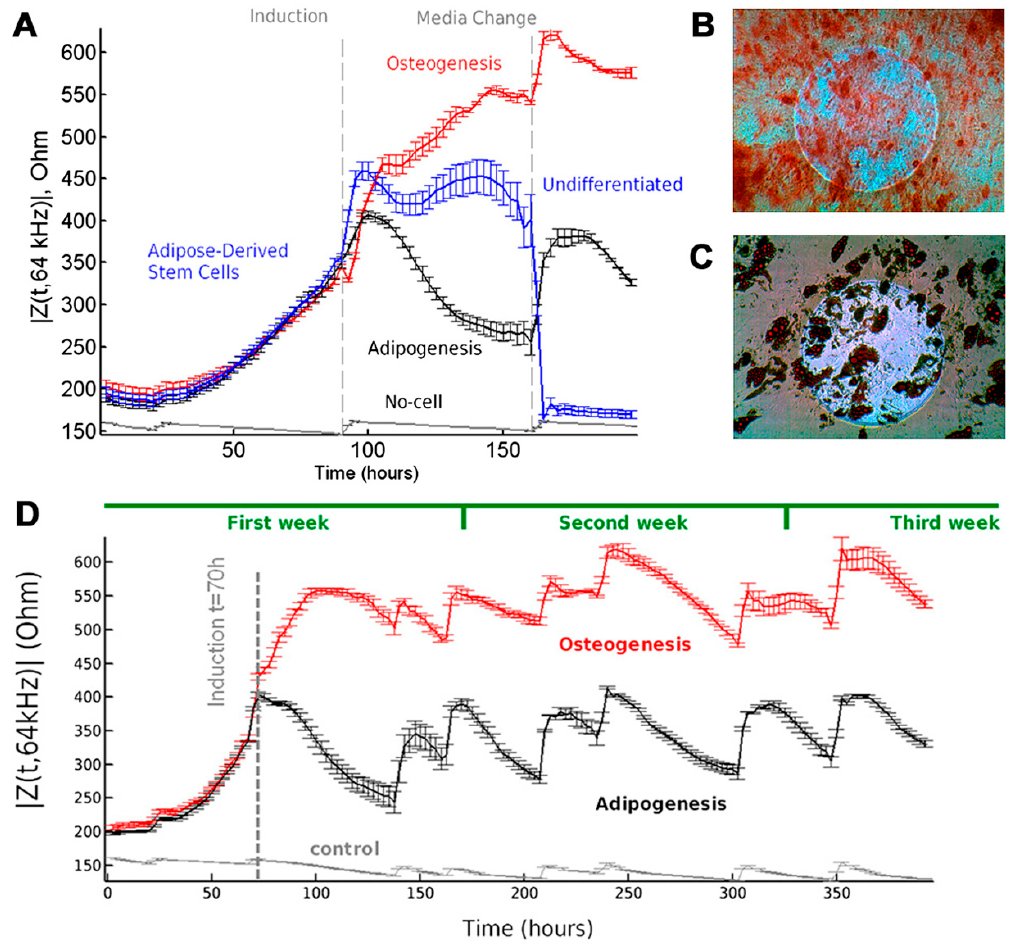
Figure 4. Real-time and label-free monitoring of MSC differentiation into osteoblasts and adipocytes. ( A ) Time-dependent measurement of mean impedance |Z(t,f)|, at 64 kHz for different groups over the course of early induction. MSCs were seeded (t = 0) in multi-well preprinted electrode arrays. At t = 93 h, MSCs were induced toward osteoblasts and adipocytes with an osteogenesis and adipogenesis differentiation medium, respectively. Non-induced MSCs kept growing after confluency until cell detachment occurred. Clear differences in |Z(t,f)| can be observed between all groups. Several days (>14) after induction, histochemical end-point staining was performed to assess if the cells underwent ( B ) osteogenesis (Alizarin red stain) or ( C ) adipogenesis (Oil red O stain). The circular microelectrodes had a diameter of 250 µm and appeared as a bright circle on the micrograph. ( D ) Long-term monitoring of |Z(t,f)| is demonstrated during differentiation over a period of 420 h and plotted at 64 kHz. At t = 70 h, the MSCs were induced toward osteoblasts and adipocytes (n = 3). Reprinted with permission from [52]. Copyright 2018, National Academy of Sciences.